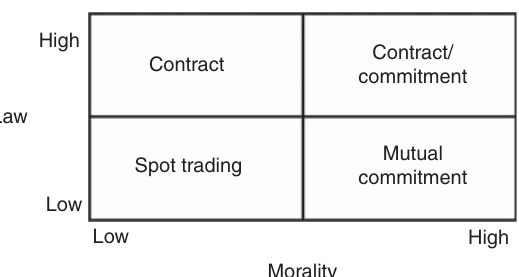
Table I. Comparison of three models